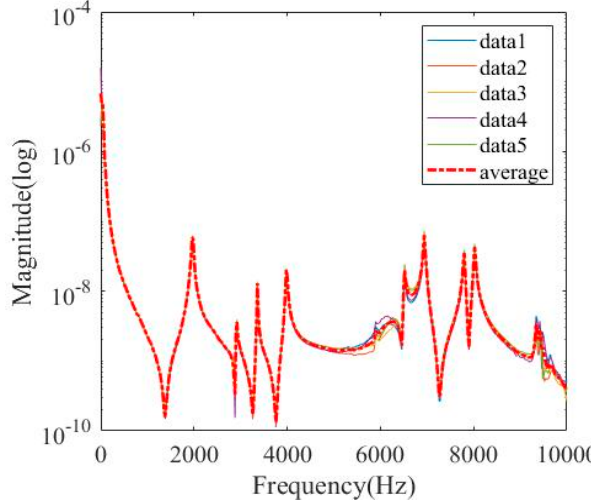
Figure 4. FRF results of five experimental and average values.